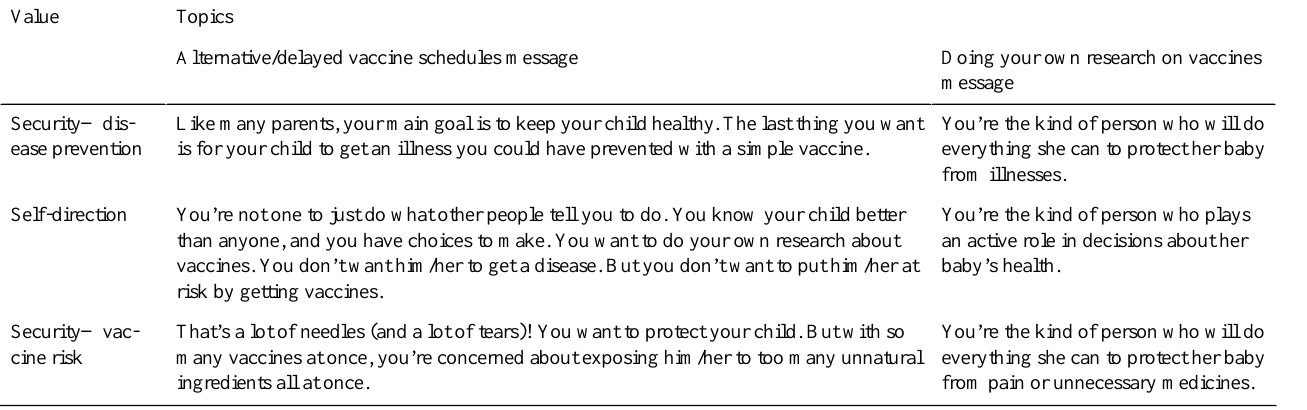
Table 1. Examples of values-tailored messages. (Vaccines and Your Baby: Tailored Messages.)